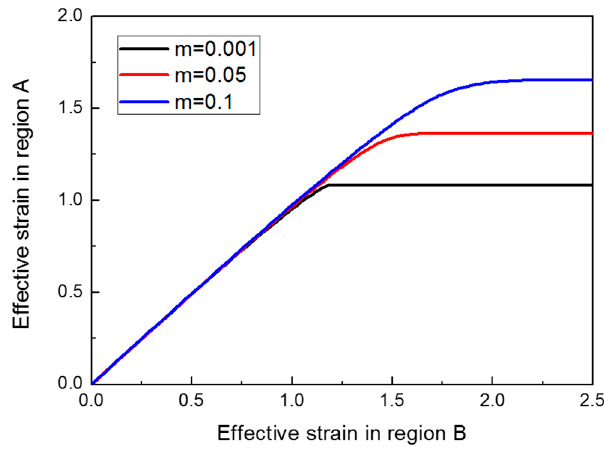
Figure 12. Deformation behavior of regions A and B according to the m value.